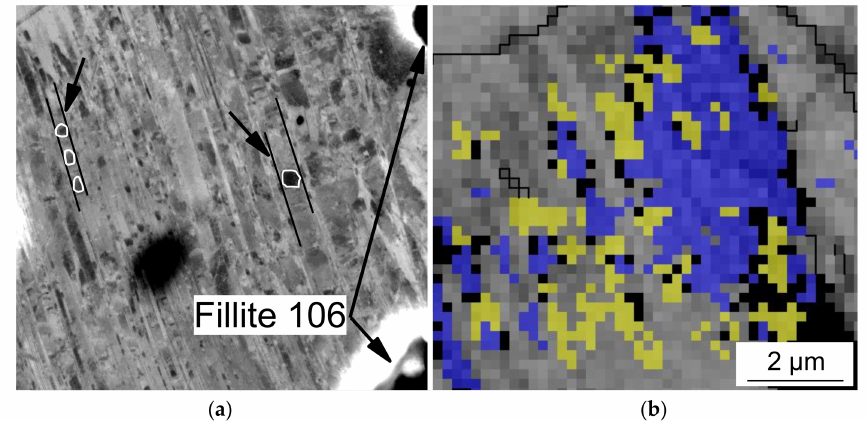
Figure 10. ( a ) BSE image (arrows indicate α (cid:48) -martensite within deformation bands) and ( b ) EBSD phase map of the syntactic foam with 20 vol % Fillite 106 after 20% quasi-static deformation; for EBSD: grey—band contrast of austenite, yellow— ε -martensite, blue— α (cid:48) -martensite, black dots—not indexed, black line—High Angle Grain Boundaries (HAGBs), coincidence site lattice CSL